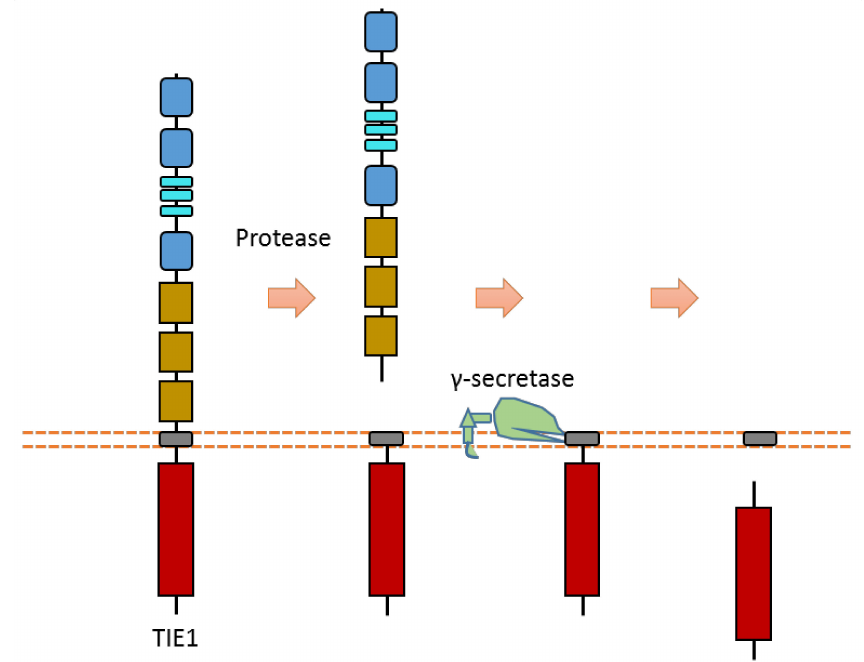
Figure 12. Schematic illustration of proteolytic cleavage in